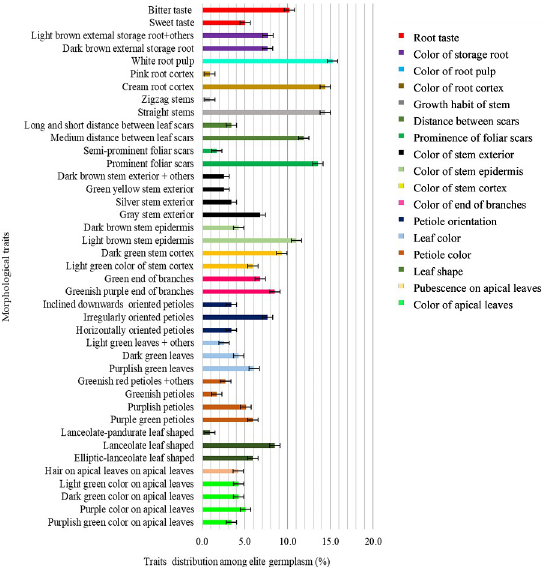
Fig 3. Morphological traits distribution among the elite germplasm with error bars indicating whether differences are statistically significant.